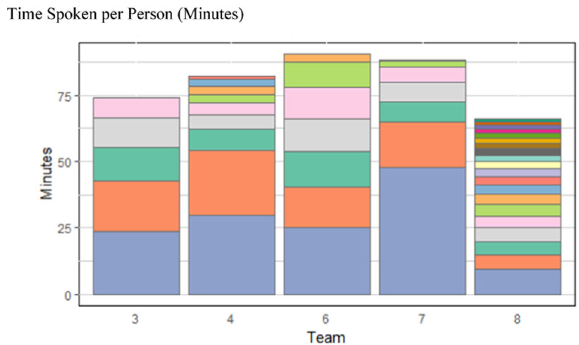
Fig. 3 Time spoken per